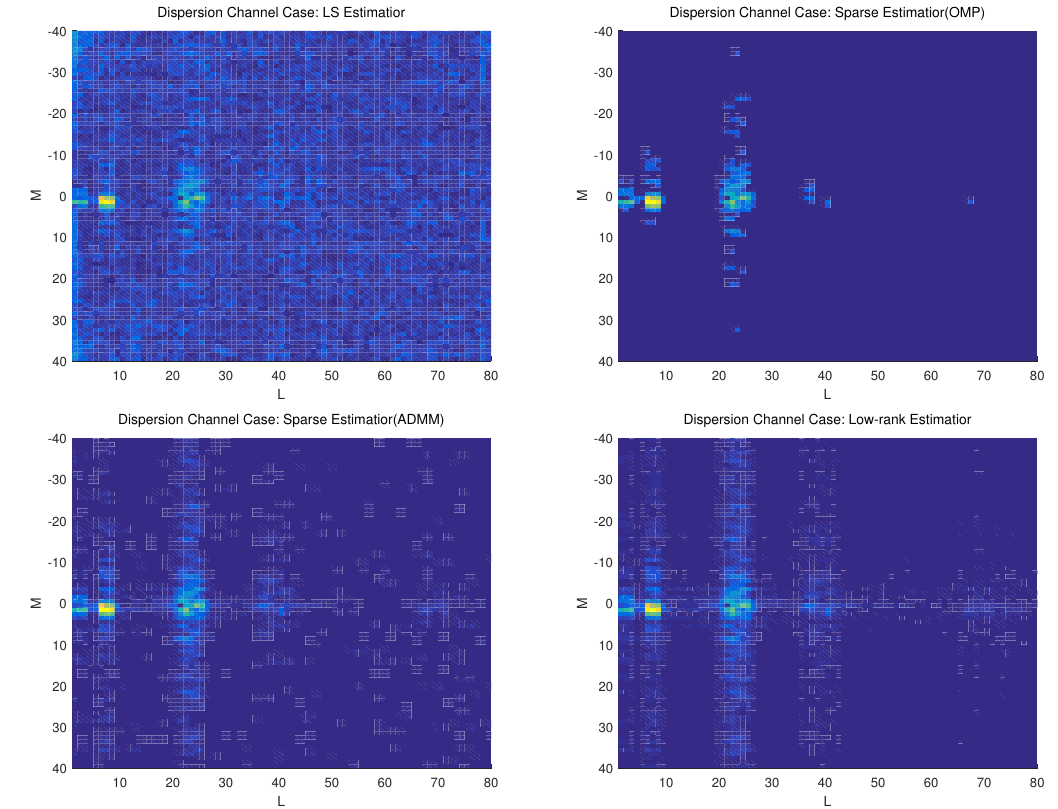
Figure 4. DDSM estimated by different estimators under dispersion channel case. ( a ) LS method; ( b ) Sparsity-based Method; ( c ) Low-rank-based